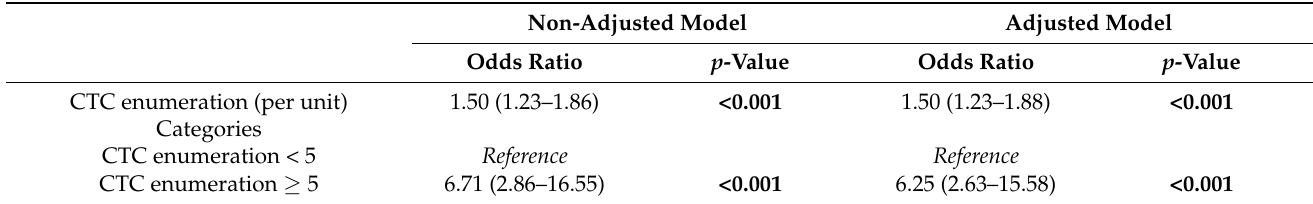
Table 3. Association of circulating tumor cell enumeration with tumor metastasis.